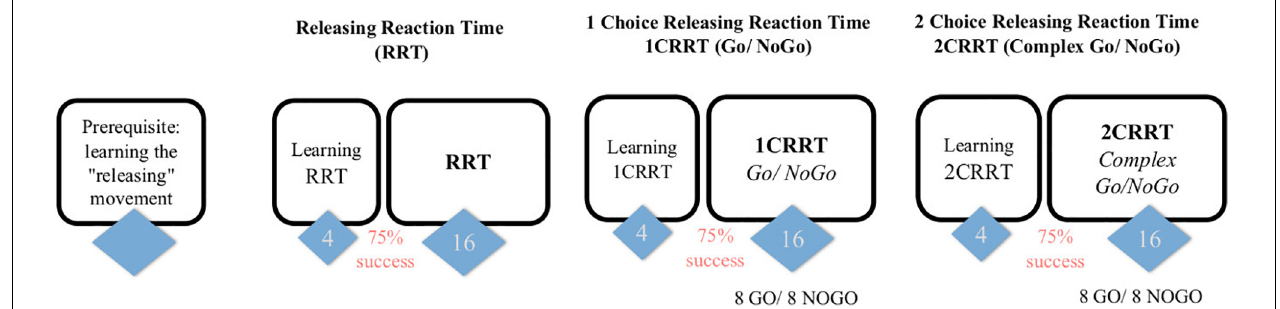
FIGURE 1 | Subjects first learn the releasing gesture (subject is in front of the screen and responds with the mouse, the response is by releasing the mouse rather than clicking) and then have 3 tasks, of increasing difficulty, each one preceded by a learning part (4 trials and 3/4 must be passed to proceed to the test part). The first task consists in a “simple Releasing Reaction Task” (RRT) with 16 trials. The second is a one-choice Releasing Reaction Task (1CRRT) with 8 Go and 8 NoGo. The third is a two-simultaneous Choices Releasing Reaction Task (2CRRT) with 8 Go and 8 NoGo.